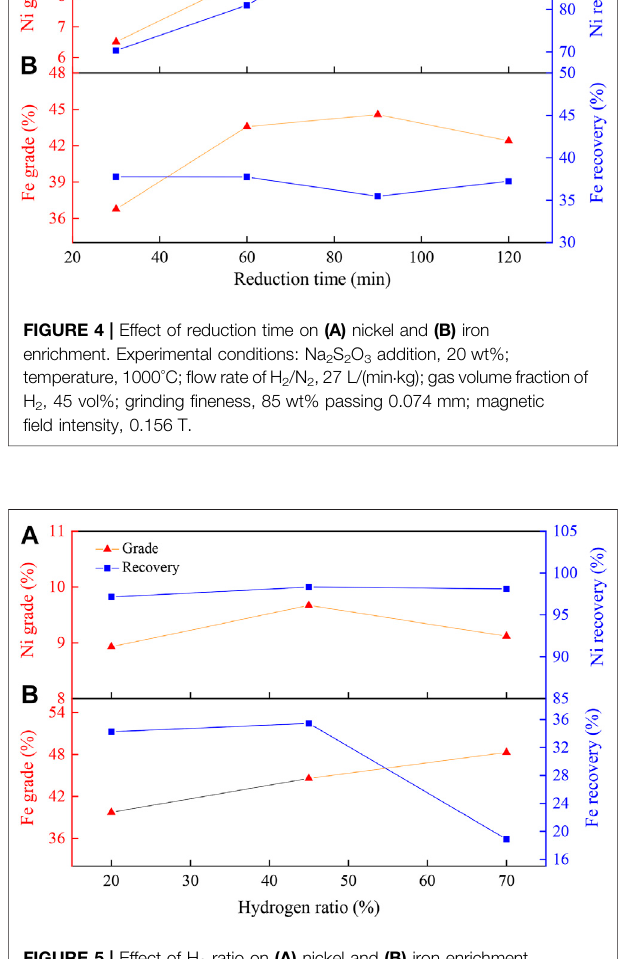
FIGURE 7 | Change of the Gibbs free energy with and without the addition of sodium thiosulfate under an H 2 atmosphere. (6): Mg 3 (OH) 4 Si 2 O 5